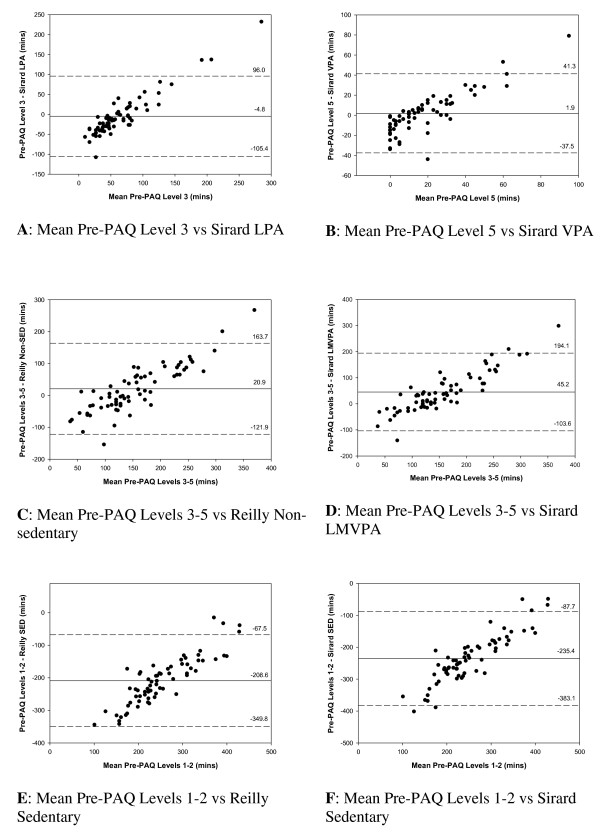
Modified-Bland Altman plots depicting mean bias and limits of agreement between Pre-PAQ and accelerometer estimates of physical activity.